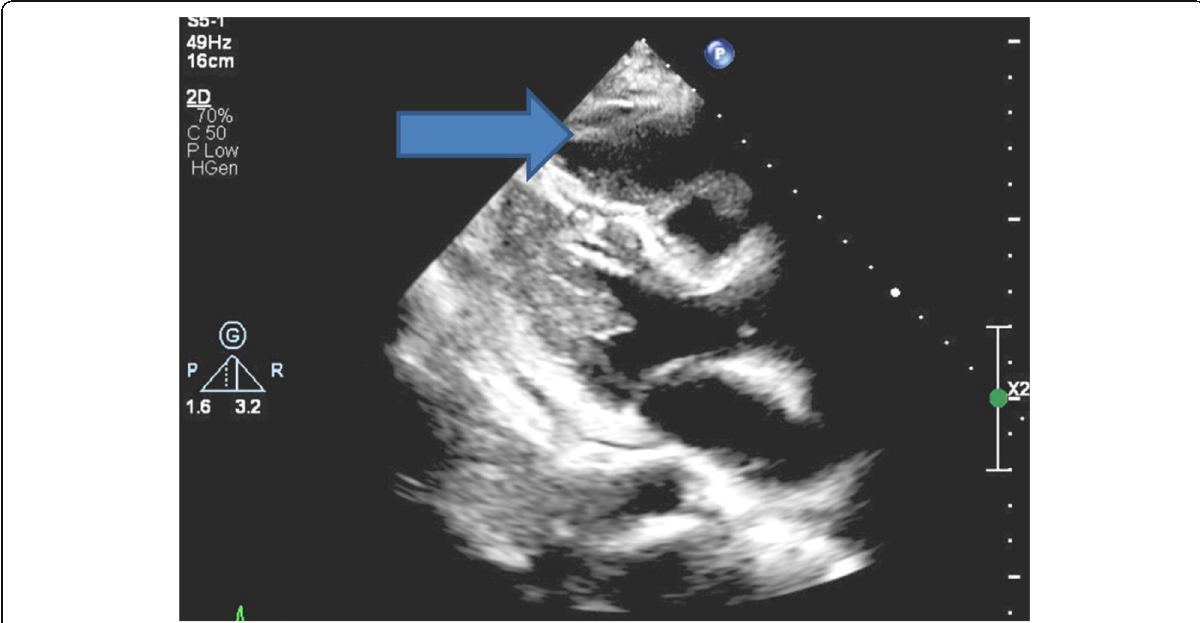
Fig. 6 Transthoracic echocardiogram parasternal long axis view demonstrates mediastinal mass anterior to the right ventricle and compressing the right ventricular outflow tract (RVOT) (blue